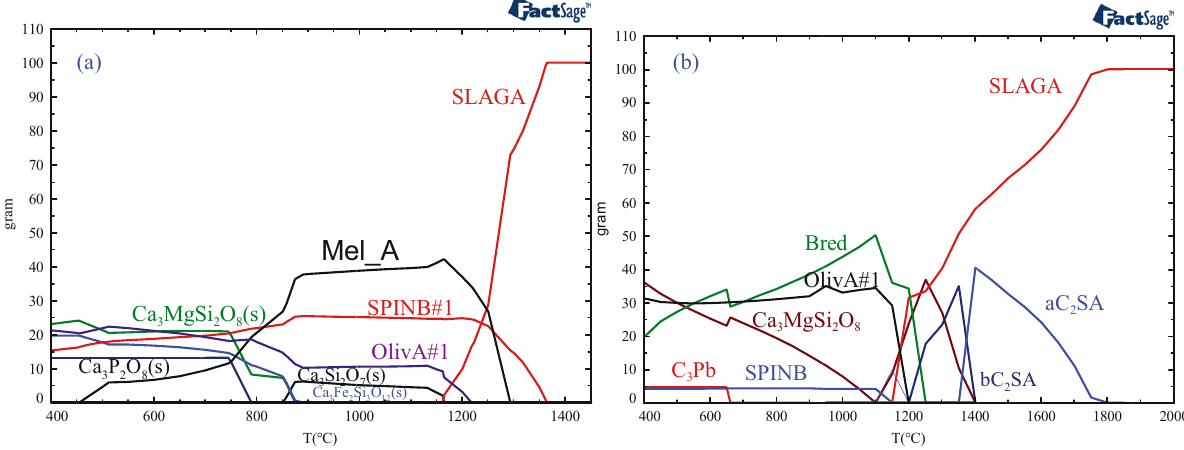
Figure 9: Main phases and precipitation behavior of slag B before and after the experiment: ( a ) R = 1.5 ( initial slag ) , ( b ) R = 1.5 ( fi nal slag ) .